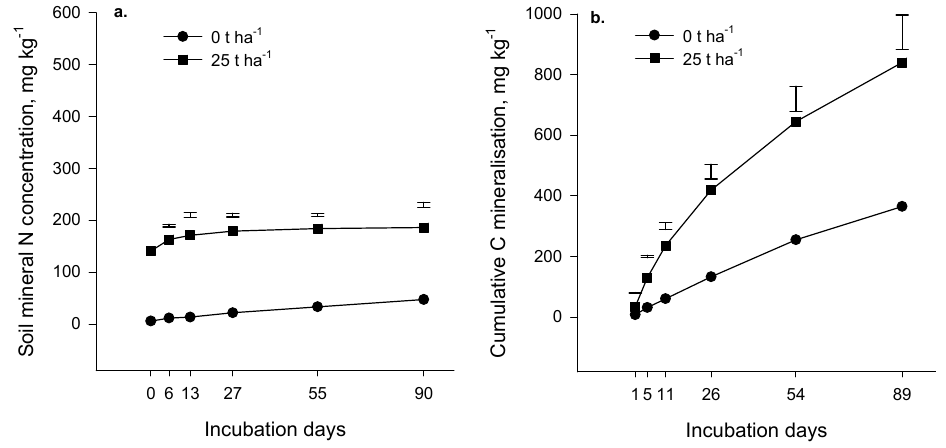
Figure 2. Arable trial incubation: ( a ) soil mineral nitrogen concentration and ( b ) cumulative carbon mineralization over a 90-day incubation with and without added compost. Bars represent 5% LSD with 7 df .